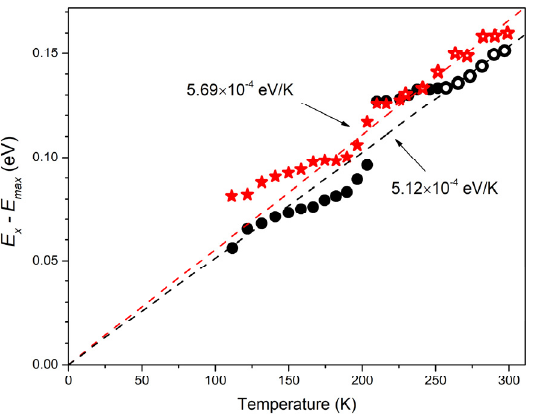
Figure 7. The energy differences between E X ( T ) and maxima of type I spectrum (black circles) and lasing spectrum (red stars) as a function of temperature; corresponding linear fitting (open symbols used) are shown by the dashed line extended to T = 0.